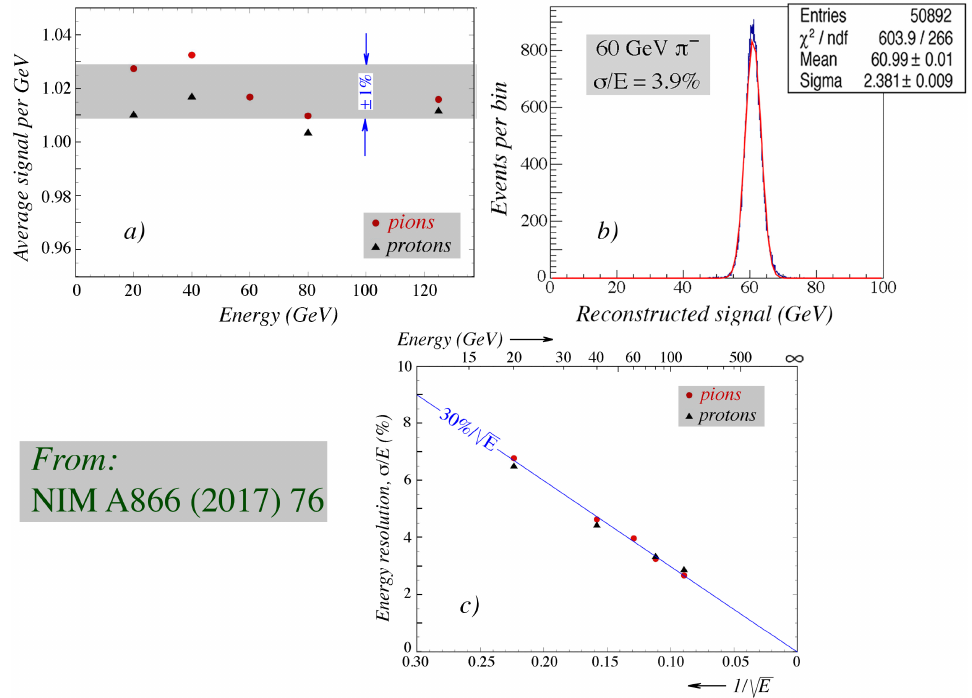
Figure 12. Results on pion and proton detection with a fine-sampling lead based dual-readout calorime- ter built by the RD52 Collaboration. Shown are results on hadron signal linearity ( a ), response function ( b ) and energy resolution ( c